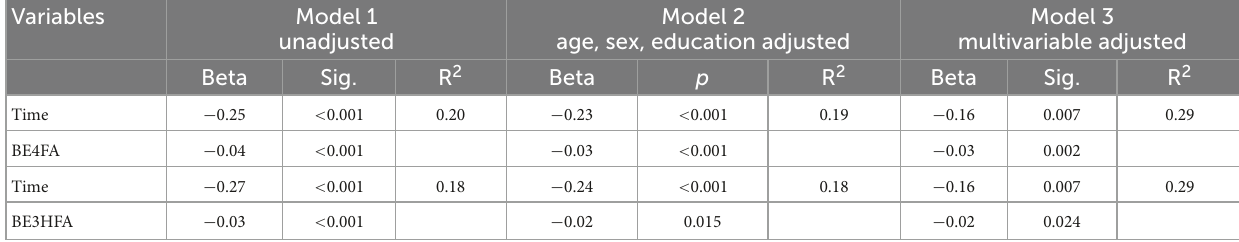
TABLE 3 Relationship between the changes of averaged hearing thresholds and HI-MoCA scores over 12 months. Variables